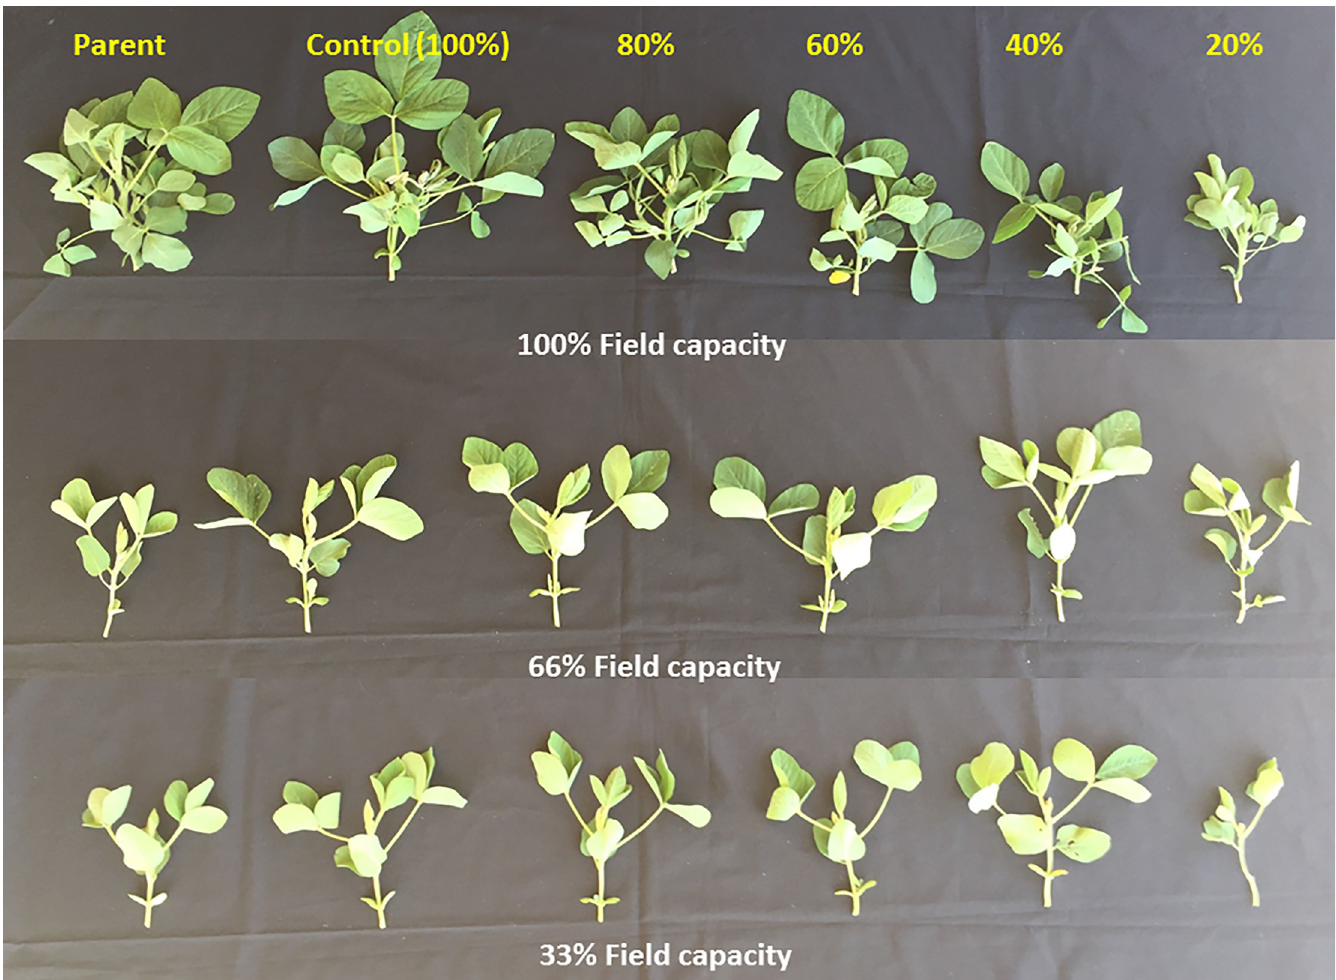
Fig 6. Shoot growth for the F1 generation of soybean cultivar Asgrow AG5332 and Progeny P5333RY exposed to drought stress including replacement of 100, 80, 60, 40, and 20% of the evapotranspiration demand.